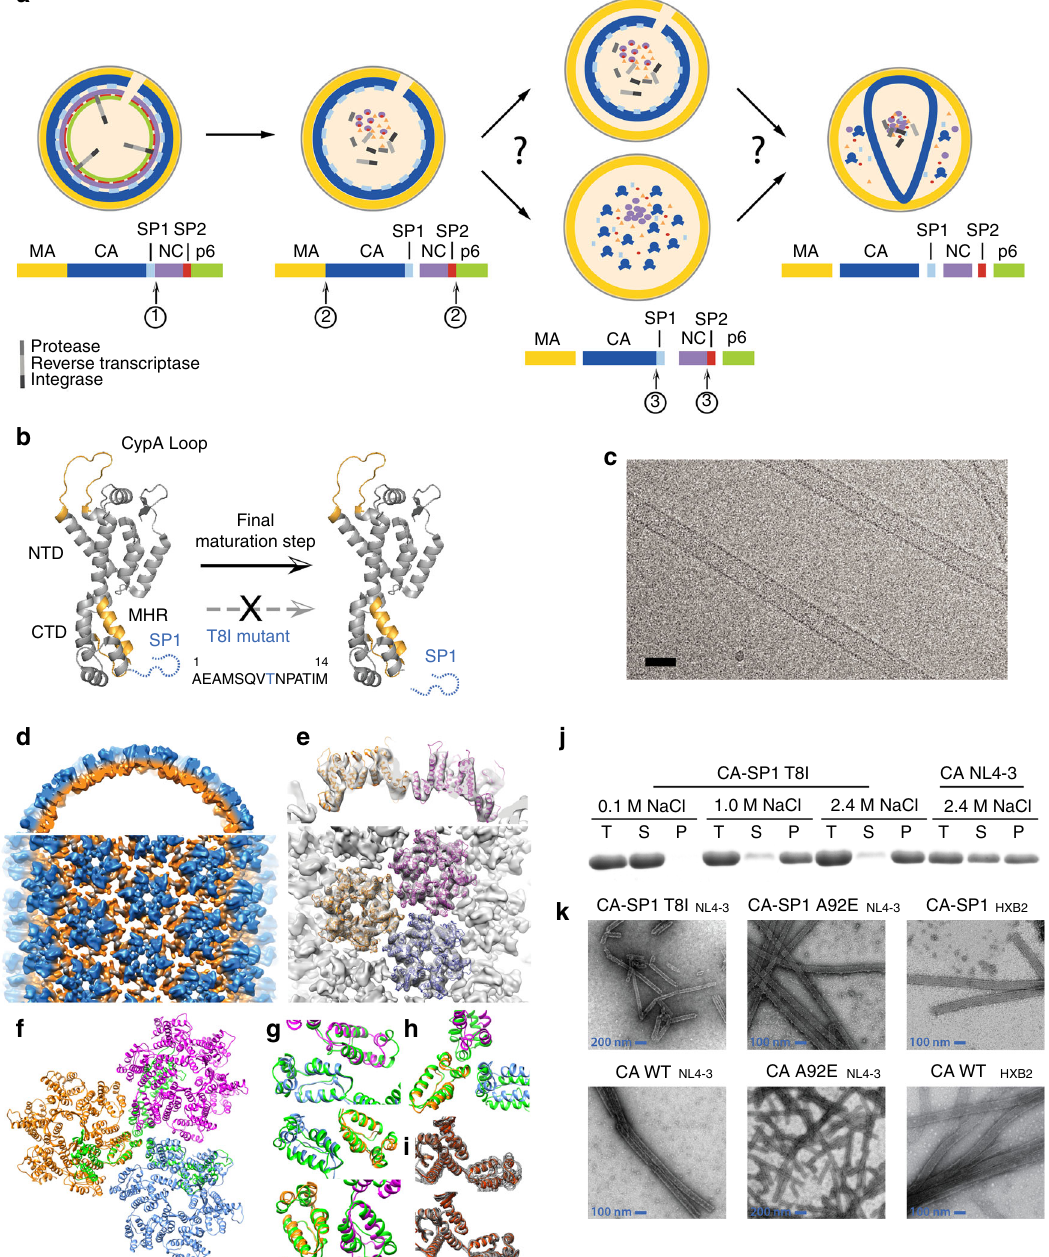
Fig. 1 a Schematic diagram of the HIV-1 Gag sequential cleavage and virus maturation process. RNA was omitted for clarity. b CA – SP1 cleavage. The ribbon diagram of the CA monomer is shown with the CypA loop and MHR highlighted in orange and the SP1 region depicted as a dotted blue line. The T8I mutation in SP1 mimics the presence of maturation inhibitors (MI) in abolishing SP1 cleavage. c A cryo-EM image of CA – SP1 tubular assemblies. Scale bar, 50 nm. d – h Cryo-EM reconstruction of CA – SP1 assemblies. d Surface rendering of the of CA – SP1 3D density map, low-pass fi ltered to 8 Å resolution. The density map (contoured at 2 σ ) is colored in orange and blue for CA – CTD and CA – NTD, respectively, viewed along (top) and perpendicular to (bottom) the tube axis. e MDFF fi tting of three CA hexamers (PDB code 4XFX, gold, magenta, and blue ribbons) into the density map. f Superposition of the ribbon diagrams of three CA molecules at the trimer interface (green, PDB code 3j34) onto the equivalent model for the CA – SP1 trimer interface (gold, magenta, and blue). g , h Comparison of the dimer ( g ) and trimer ( h ) interfaces in CA assemblies (green) to those in CA – SP1 assemblies (gold, magenta, blue). i The variabilities among the six CA molecules in CA (top) and CA – SP1 (bottom) assemblies. j Assembly assay of CA – SP1(T8I) NL4-3 and CA NL4-3 for different concentrations of NaCl. k TEM images of tubular assemblies of CA(A92E) and CA(A92E) – SP1